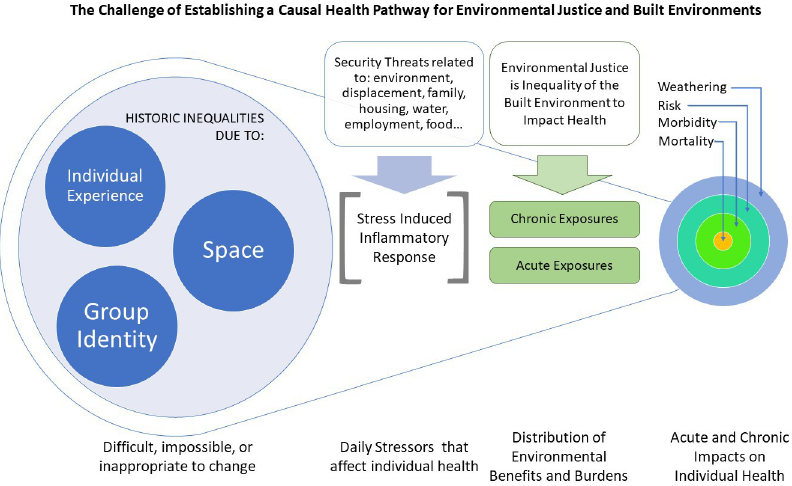
Fig 5. A non-causal model prioritizing improvement to built environments to counter deteriorating conditions and buffer vulnerable